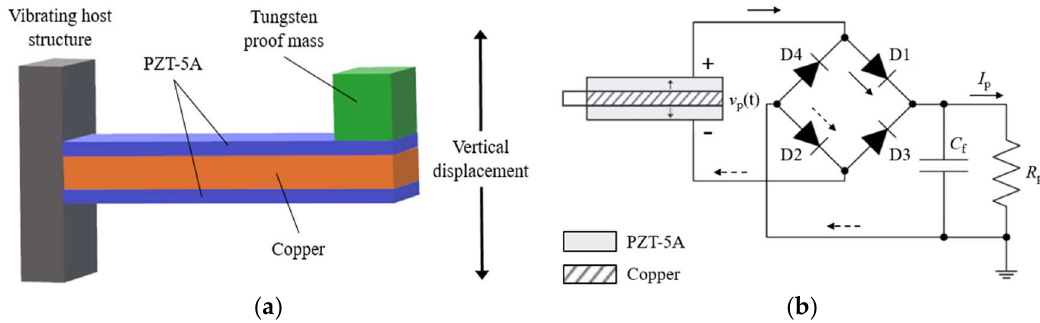
Figure 1. Proposed CB: ( a ) Structural composition. ( b ) Equivalent circuit with AC-to-DC rectification.